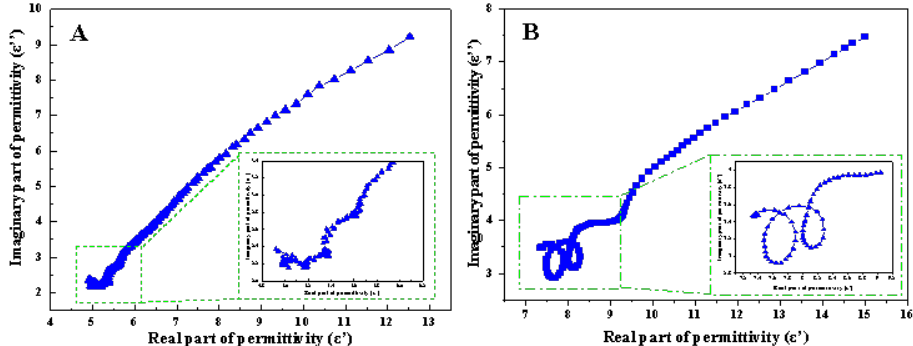
Figure 10. The real part (ε′) versus imaginary part (ε″) curve of the dielectric constant of magnetic composite microspheres: Fe@C-12 ( A ) and Fe 3 O 4 @C-700 ( B ).